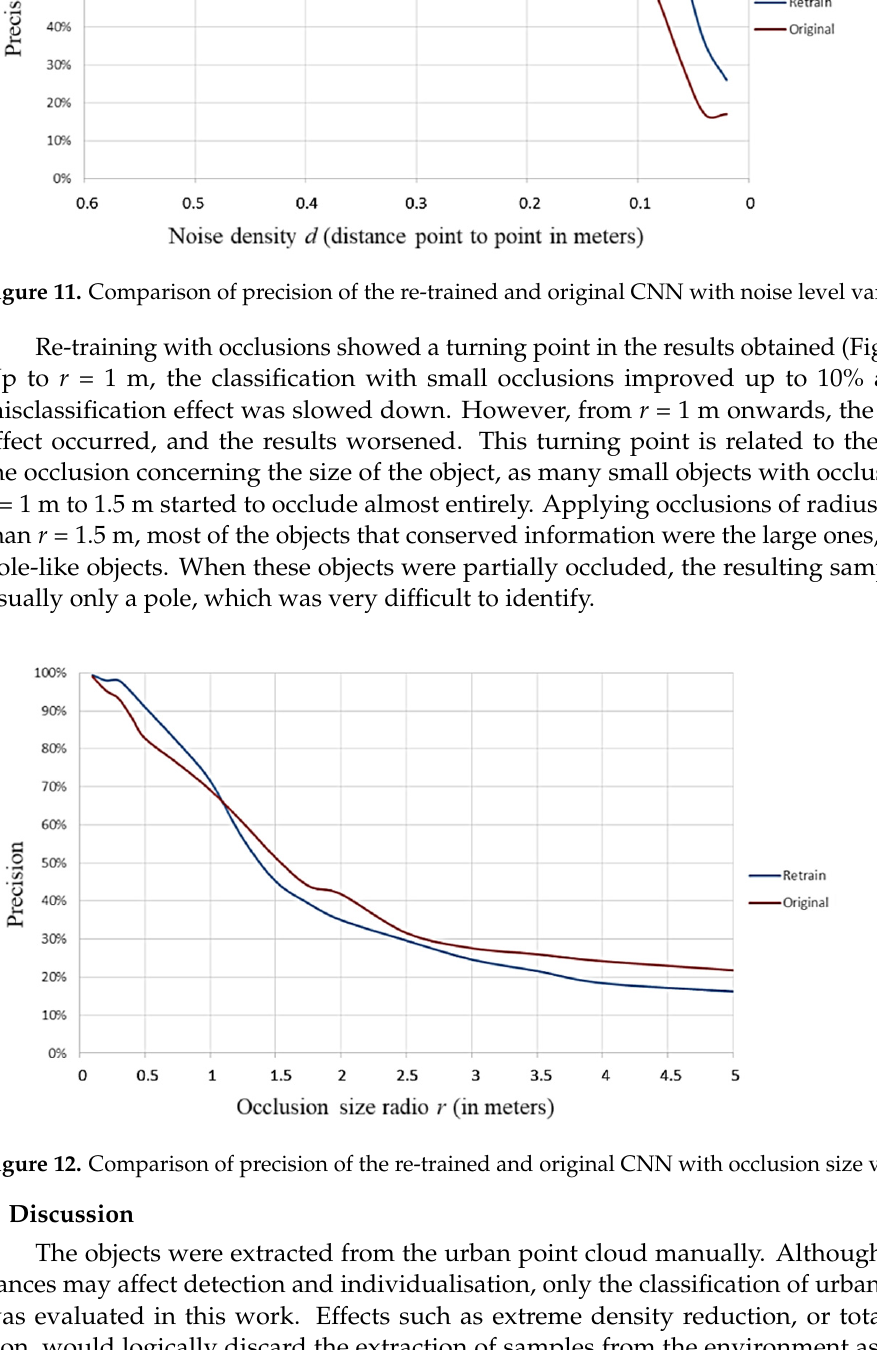
Figure 12. Comparison of precision of the re-trained and original CNN with occlusion size varia- tion.